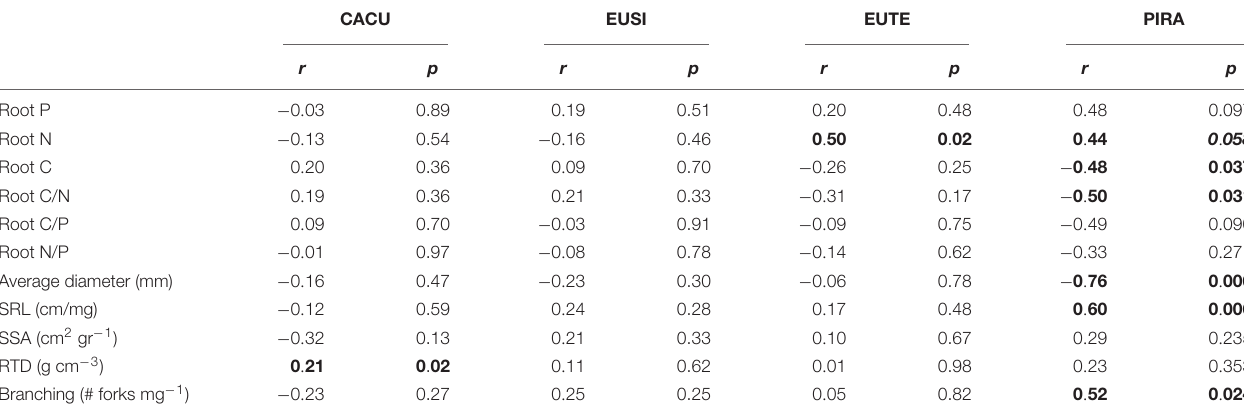
FIGURE 3 | Decomposition rate of roots produced under water and nutrient availability treatments for each of the studied species. Values are mean decomposition rates as CO 2 release from roots incubated in sand per gram of root ± standard error ( n = 6) across the full incubation duration. HW, high water, LW, low water, HN, high nutrient, LN, low nutrient. p -values are from significant effects from three-way ANOVA (Water, Nutrients, Species) with interactions. CACU, Casuarina cunninghamiana; EUSI, Eucalyptus sideroxylon; EUTE, Eucalyptus tereticornis; PIRA, Pinus radiata. TABLE 3 | Correlations between roots traits and decomposition rates per species. CACU